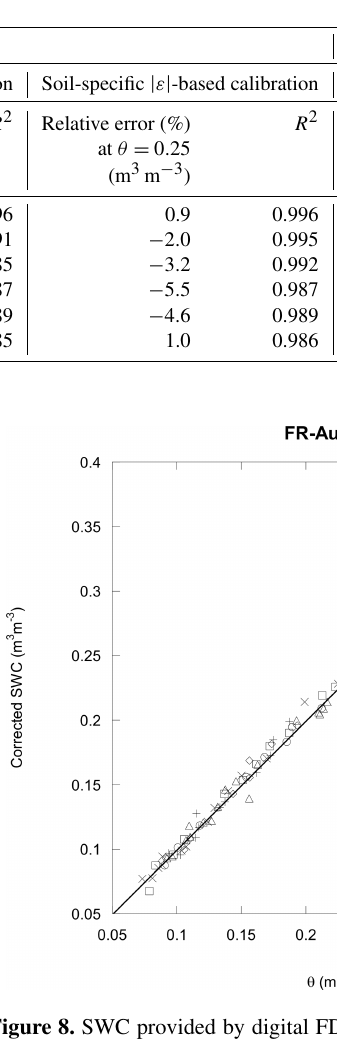
Table 3. Fr-Aur, pit A: relative errors and coefficient of determination before and after calibration.